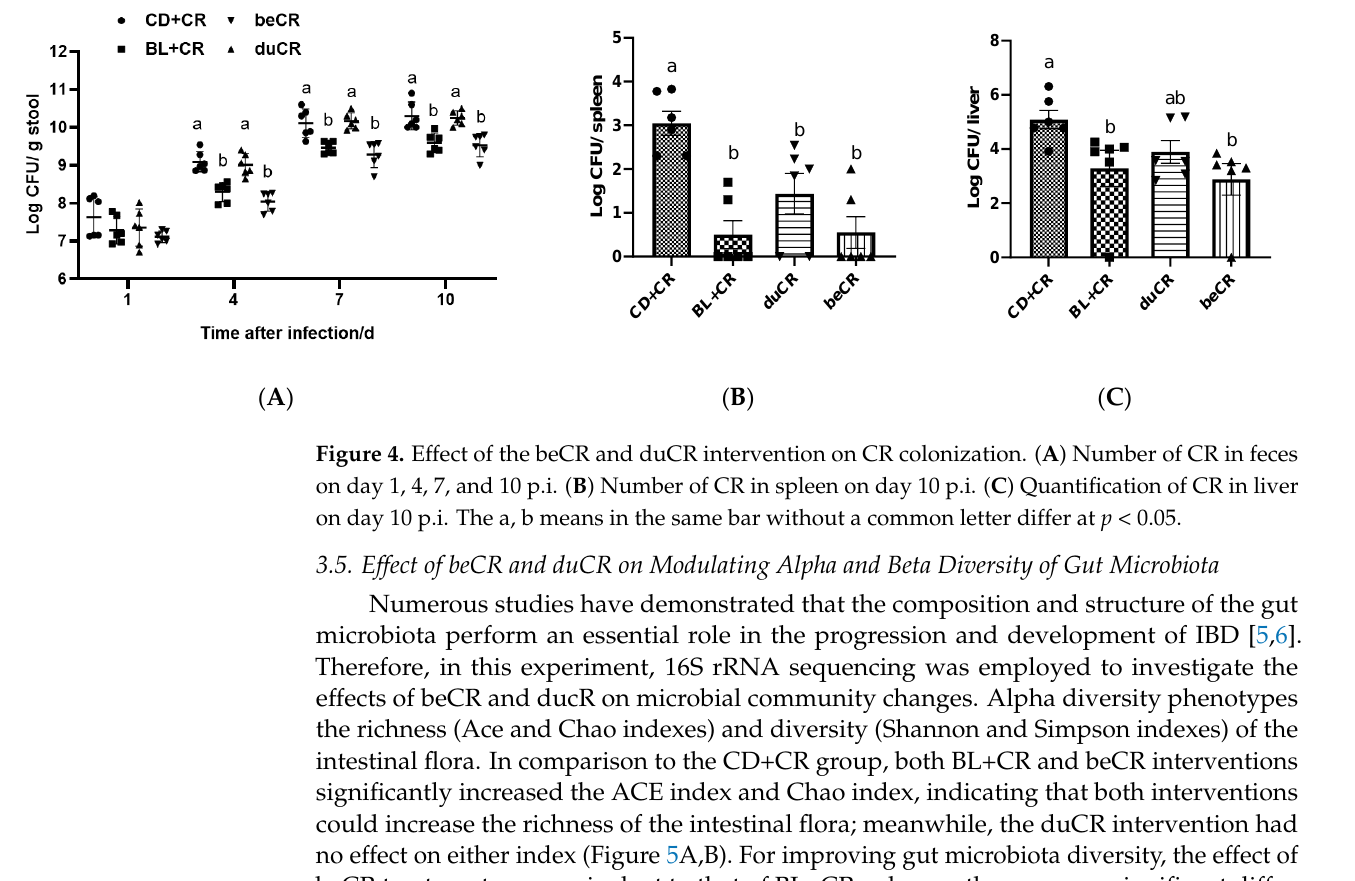
( D ) Figure 3. Effect of the beCR and duCR intervention on inflammatory cytokines in colon. The con- centrations of anti-inflammatory cytokines (IL-4) ( A ) and pro-inflammatory cytokines IL- 1β ( B ), TNF- α ( C ), and IFN γ ( D ) in colonic tissue of mice. The a, b means in the same bar without a common letter differ at p < 0.05. 3.4. Effect of beCR and duCR on CR Colonization To investigate the effect of beCR and duCR interventions on CR colonization in the intestine of mice, we collected mouse feces on days 1, 4, 7, and 10 after CR infection, and bacterial CFUs were enumerated by dilution and plate counts. On day 1 p.i., there was no